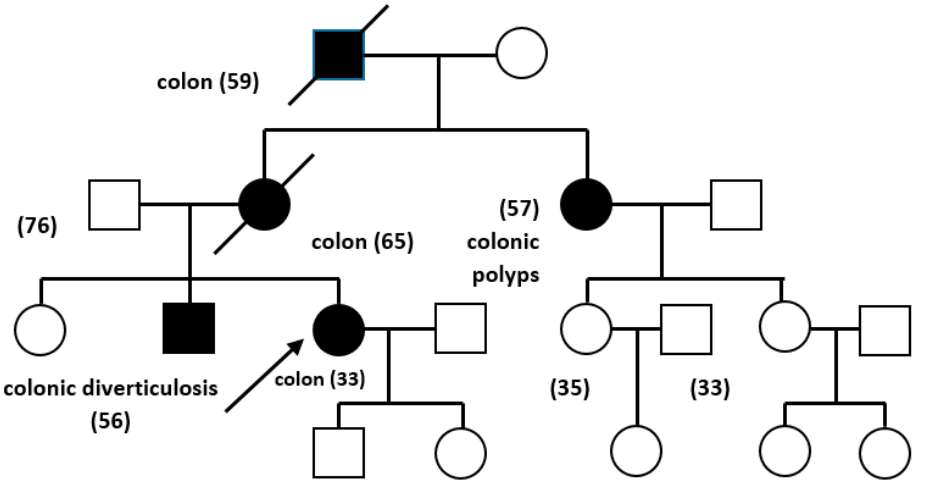
Figure 1. The genetic tree of a patient included in the present study.